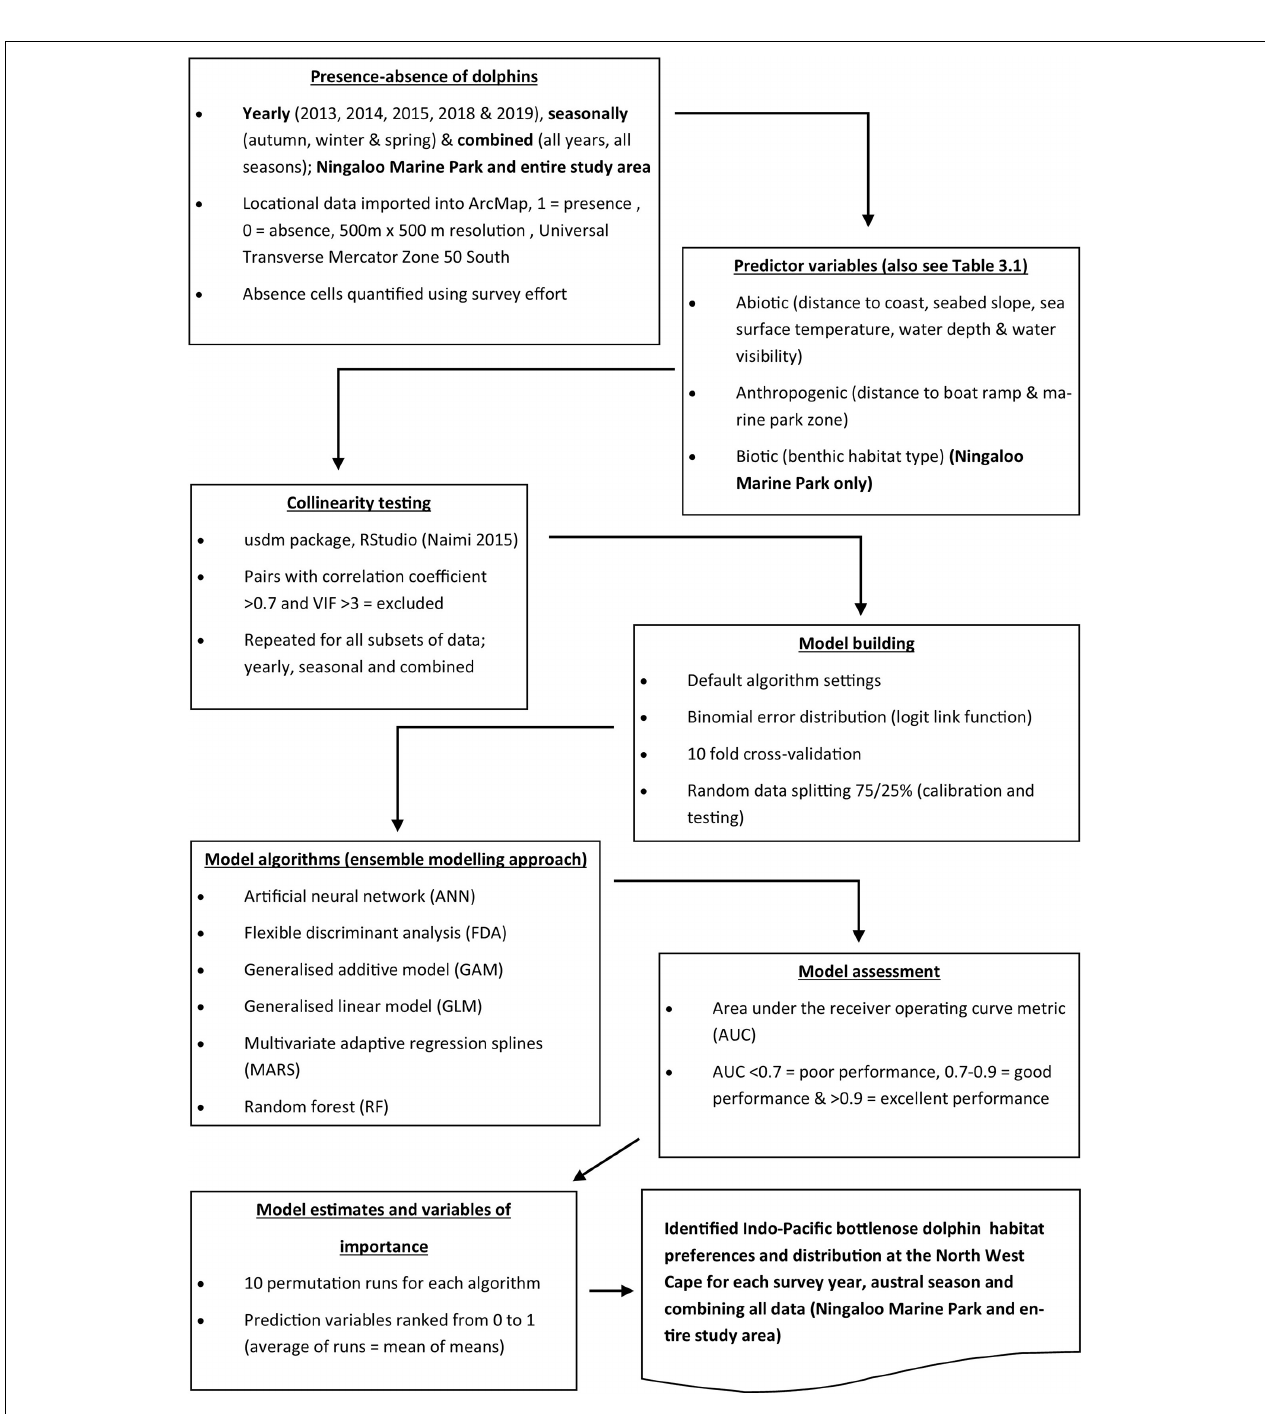
FIGURE 3 | Flowchart summarising the data analysis process used for ensemble modelling of Indo-Pacific bottlenose dolphin ( Tursiops aduncus ) habitat preferences and distribution at the North West Cape, Western Australia.